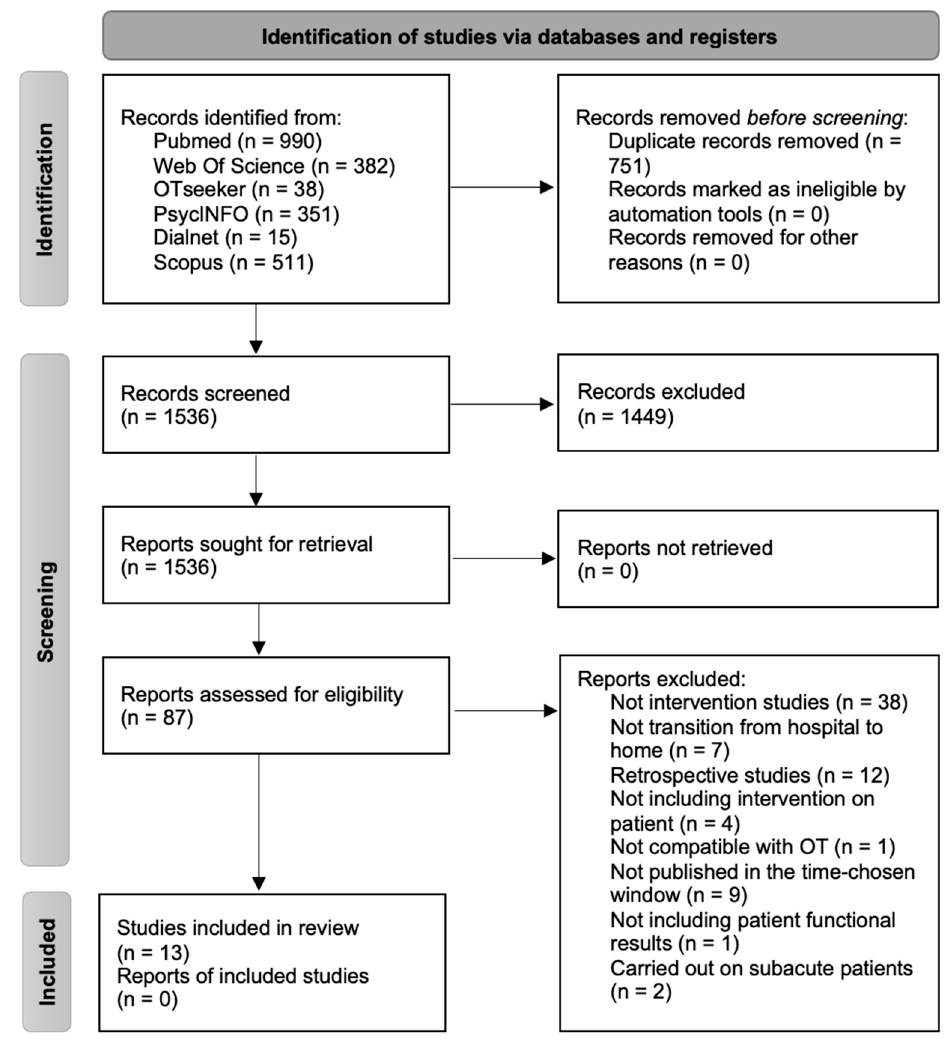
Figure 2. PRISMA 2020 flow diagram.